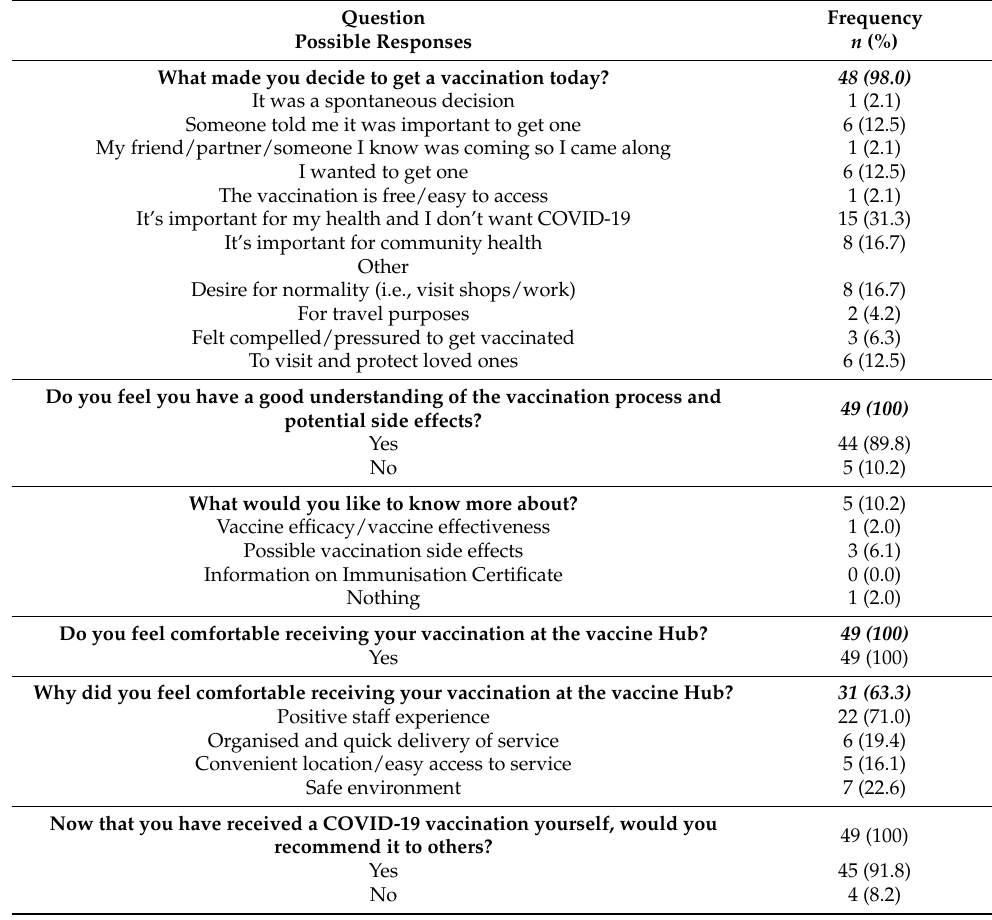
Table 3. COVID-19 Vaccination Hub Survey questions and respondents (inner-city Sydney study population) answer frequencies and percentages ( n =